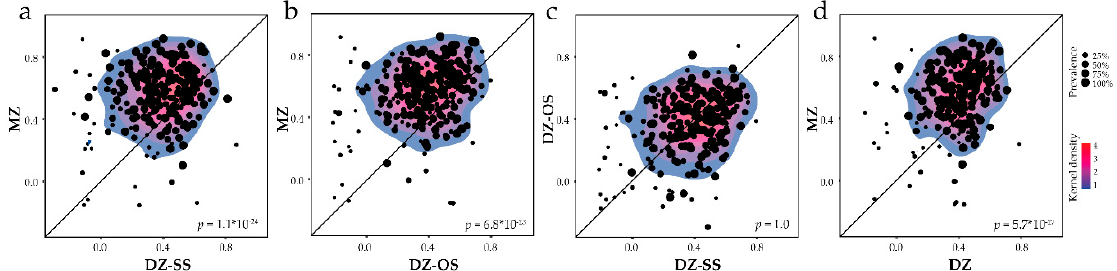
Figure 3. Scatter plot of intraclass correlation coefficient in MZ versus DZ twins. ( a ) bacterial species intraclass correlation coefficient (ICC) plotted for MZ versus DZ-SS twins, ( b ) MZ versus DZ-OS twins, ( c ) DZ-SS versus DZ-OS twins, and ( d ) MZ versus all DZ twins. ICC values are presented for species with a prevalence ≥ 5%. Each dot represents a single species with the dot-size indicating the species prevalence. The line represents the diagonal where X = Y. The Mann–Whitney U tests were used for group comparisons. Density was predicted using the Kernel estimation.